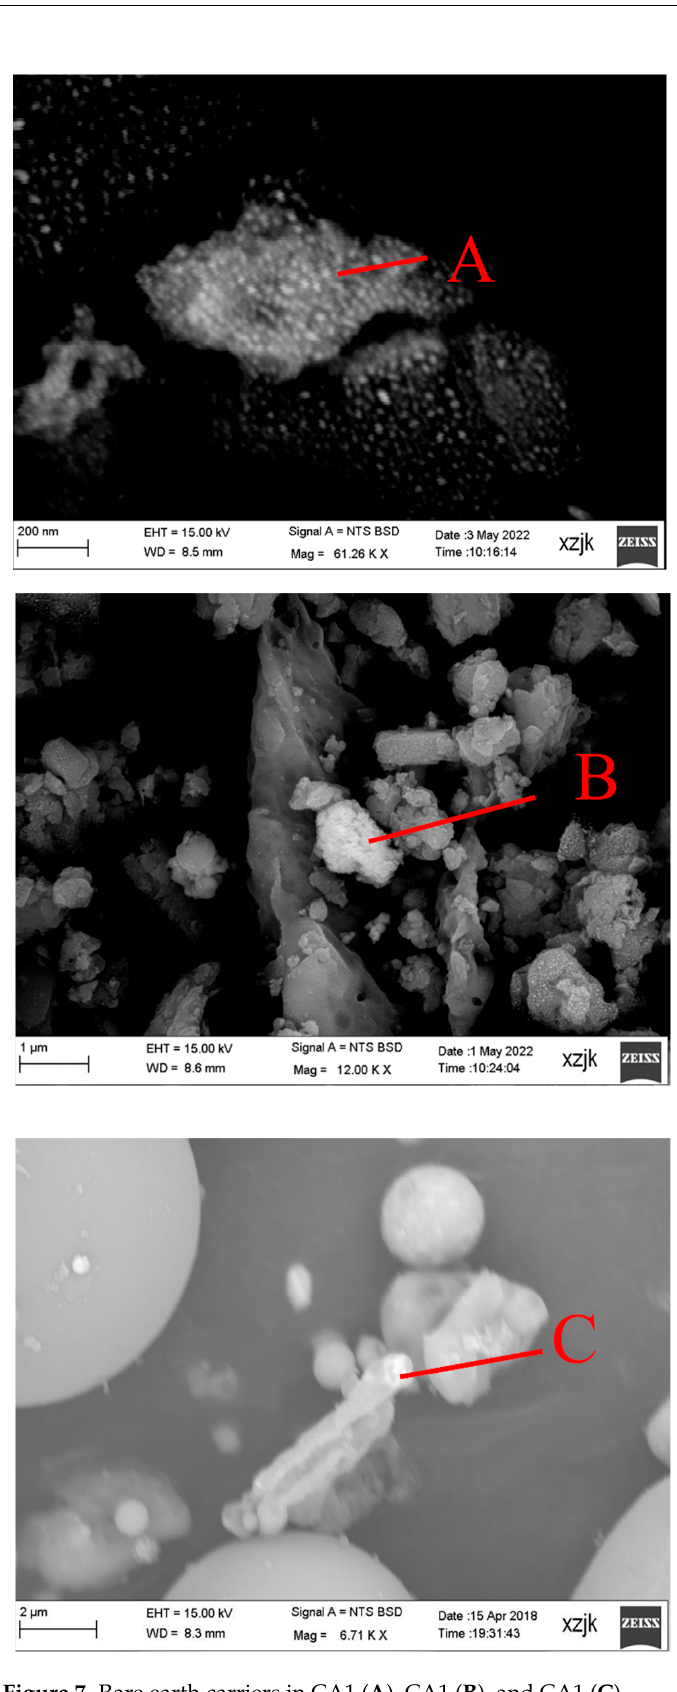
Figure 7. Rare earth carriers in CA1 (A), CA1 (B), and CA1 (C). Table 4. The EDS analysis of points in Figure 7.